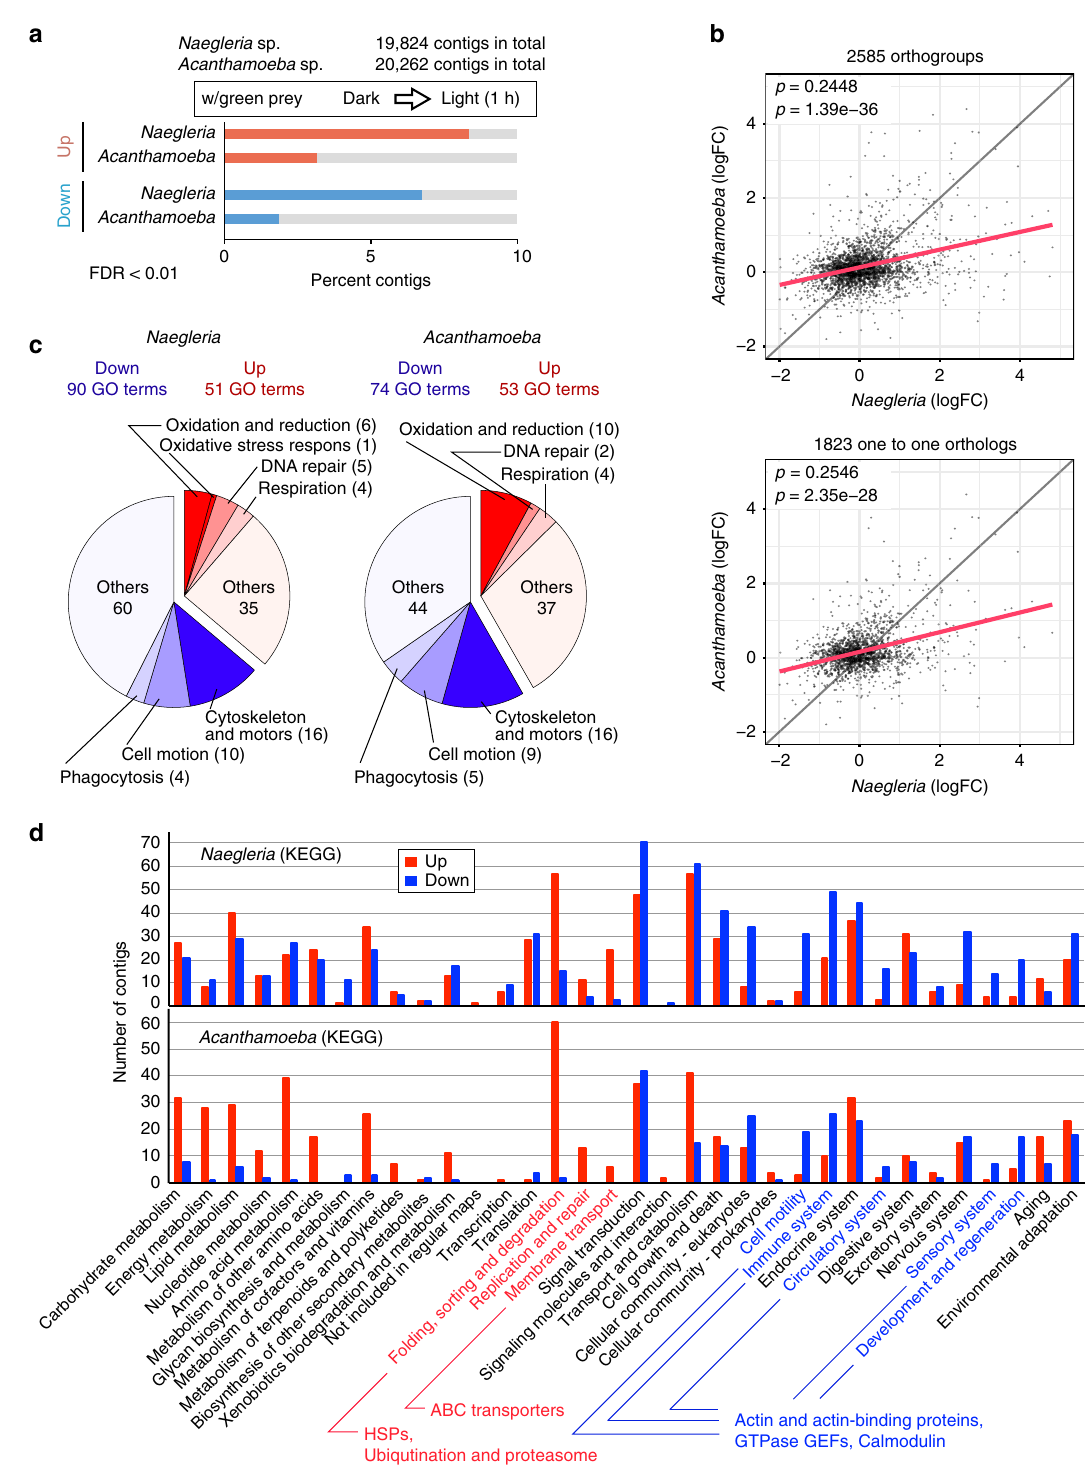
acclimated to the phototoxicity of green prey by 90 min after the onset of illumination. Because the growth of the two species of amoebozoans became unstable after long-term storage, as described above, we obtained three independent replicates (cells were cultured independently on different days) of RNA-seq datasets (light vs. dark) in the excavate Naegleria sp. and the amoebozoan Acanthamoeba sp., but only two replicates in the amoebozoan Vannella sp. (Supplementary Fig. 3). Thus, statistical analyses by edgeR 21